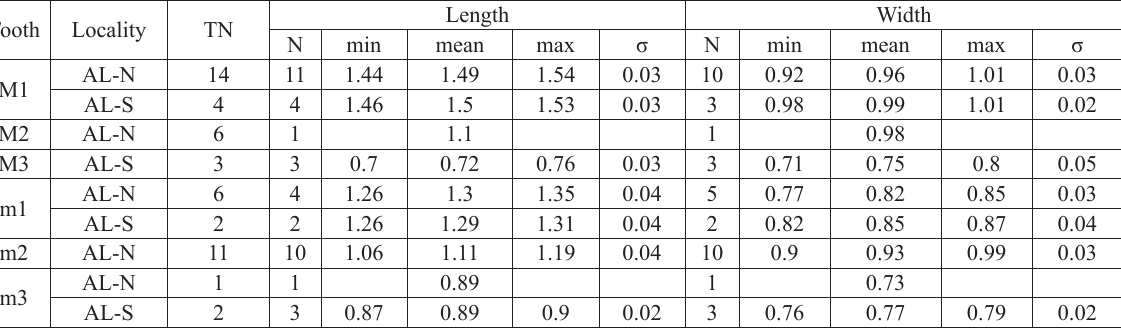
Table 1. Measurements (in mm) of the upper and lower molars of Megacricetodon hellenicus sp. nov. from the North and South quarries, Greece (MN4, Early Miocene). TN, total number of teeth; N, number of teeth measured; min, minimum; max, maximum; σ , standard deviation. Tooth Locality